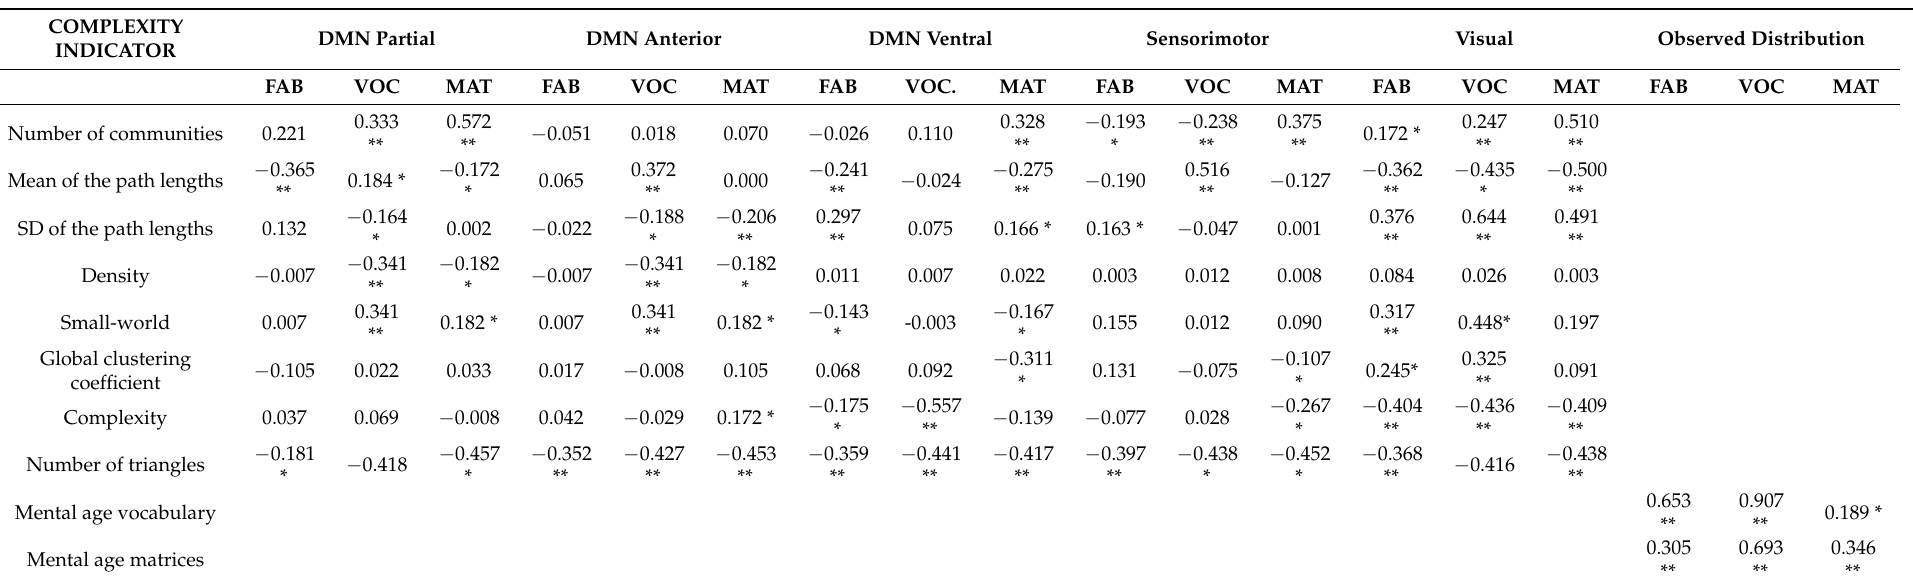
Table 5. Pearson correlations between